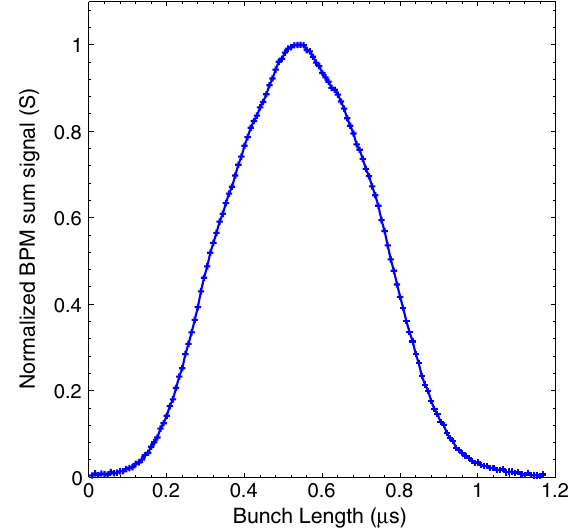
FIG. 27. A typical normalized longitudinal beam profile from the TOPOS system at injection. The length of the rf period is (cid:4) 1 : 2 (cid:12) s